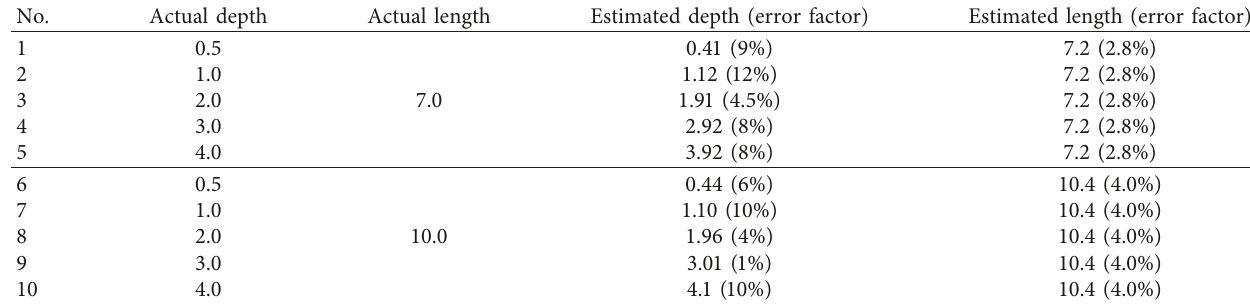
Figure 14: Change in amplitude values with variation of crack depth. Table 2: Inspection results for standard-type cracks